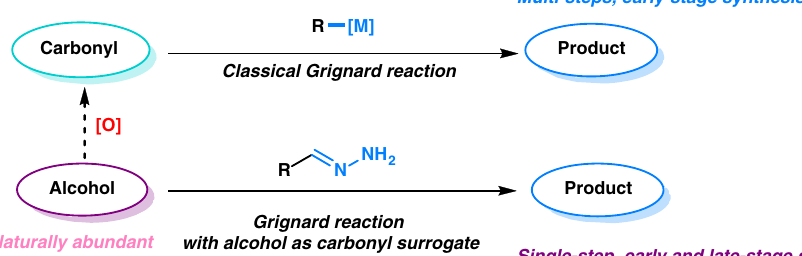
Fig. 1 Classical Grignard reaction and Grignard reaction with alcohol as carbonyl surrogate. This fi gure shows the comparison between classical Grignard reaction and the Grignard reaction with alcohol as carbonyl surrogate. It clearly shows that the latter is both step and atom economical. More importantly, using alcohol as carbonyl surrogate has a broad potential for late-stage functionalizations in synthetic